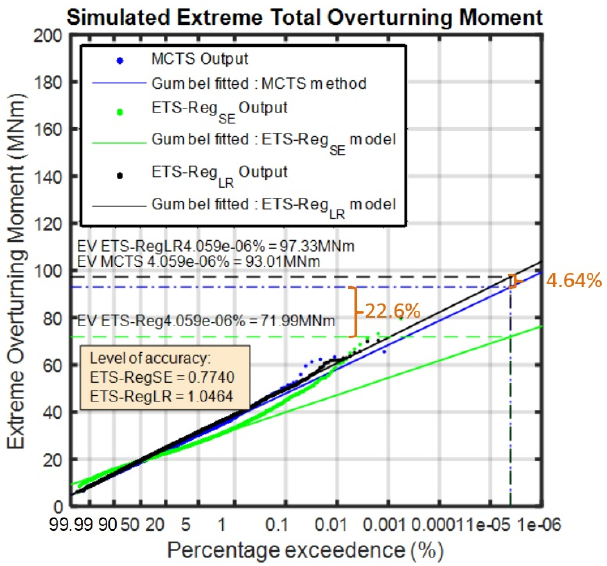
Figure 8. Comparison and validation ETS-Reg models with the MCTS method. N = 10,000, total quasi-static overturning moment responses; Hs = 5 m, Tz = 7.94 s, and U = 0.00 m/s.